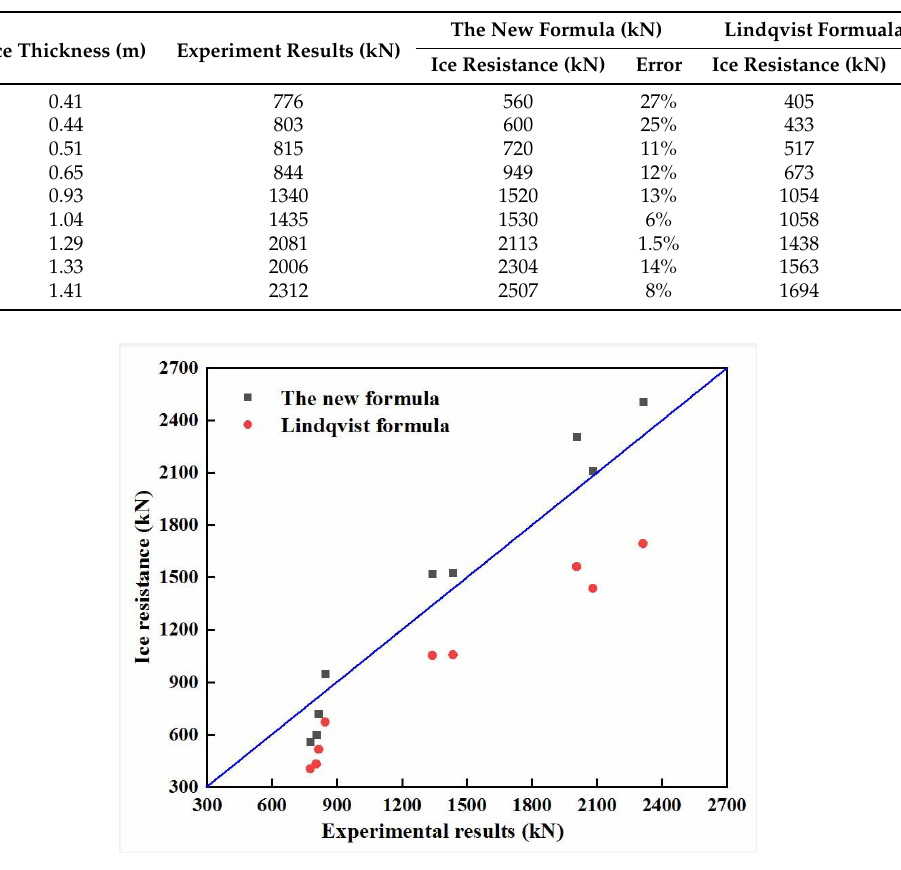
Table 2. Experiment and calculation of ice resistance of the KV Svalbard icebreaker under different ice thicknesses.